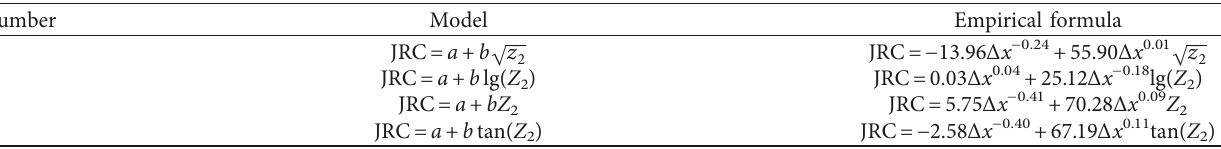
Table 4: Relationship between JRC, Z